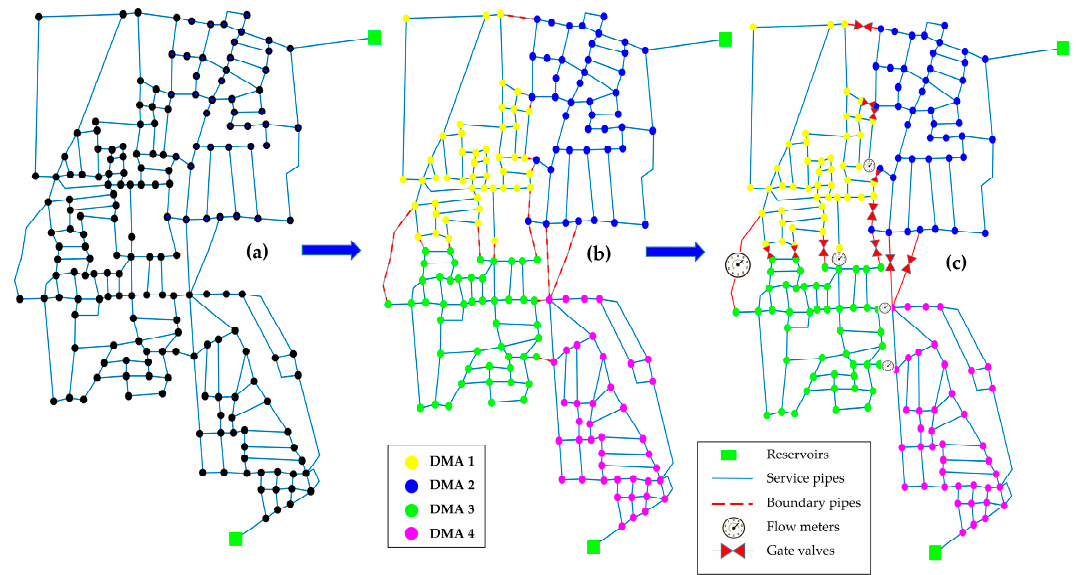
Figure 7. Illustration of the water network partitioning (WNP) procedure implemented to a water distribution network (WDN) in Parete, South Italy (adapted from Di Nardo et al. [47,49]); ( a ) original water network, ( b ) clustering phase, and ( c ) sectorization phase.